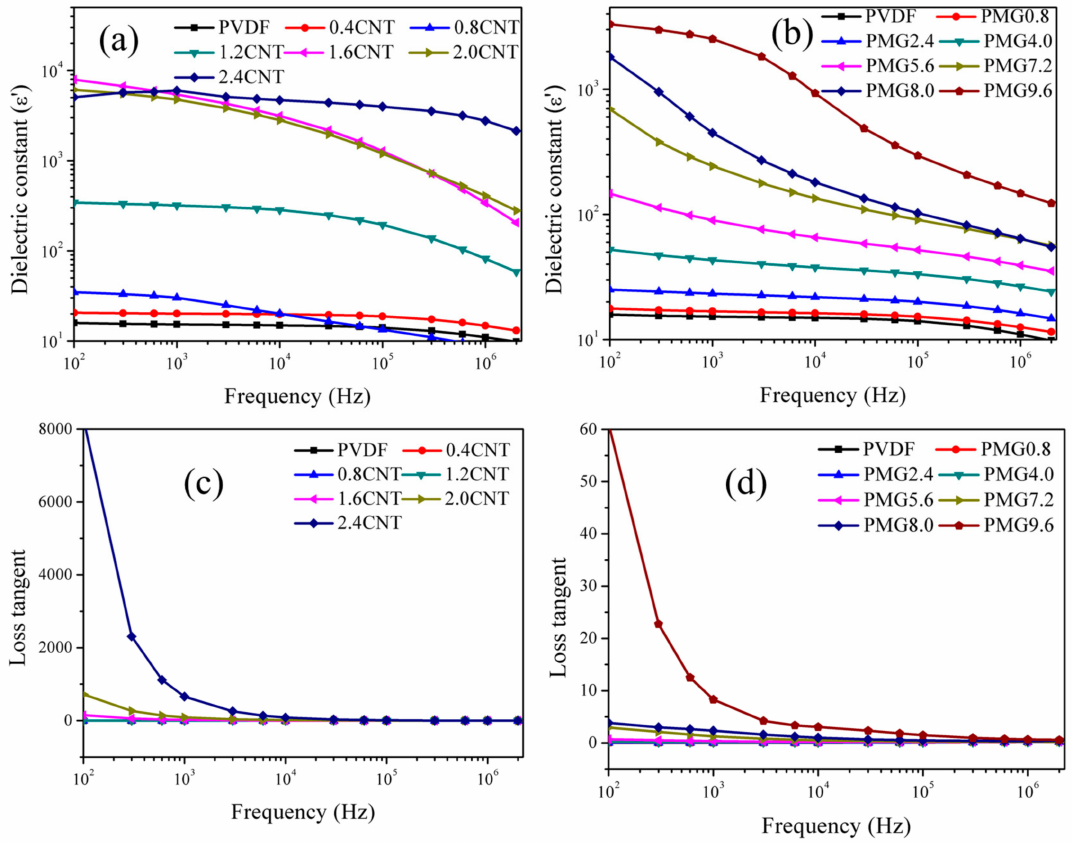
Figure 7. Frequency dependent of c-MWCNTs/PVDF and c-MWCNTs/MG/PVDF composites with different c-MWCNTs contents: ( a , b ) dielectric constant, ( c , d ) loss